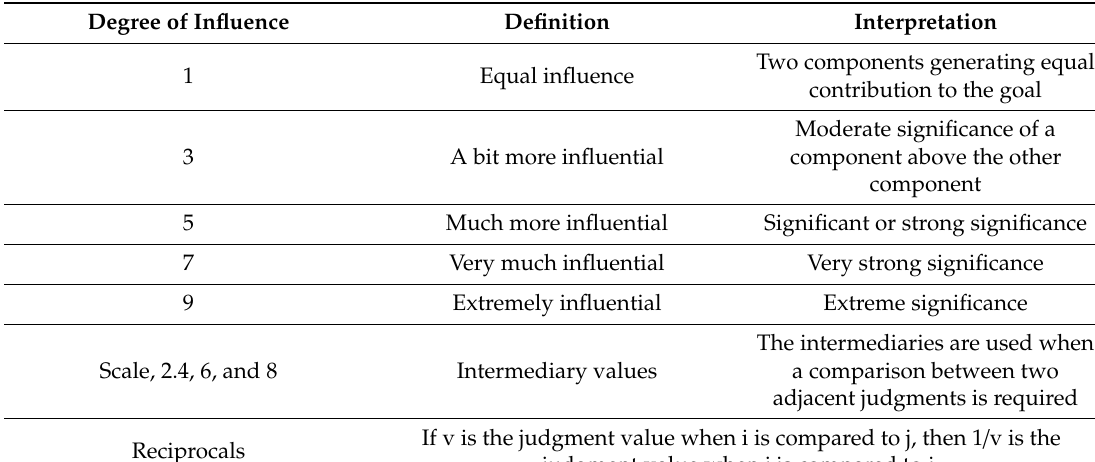
Table 2. Saaty’s fundamental scale of judgment (source: Saaty